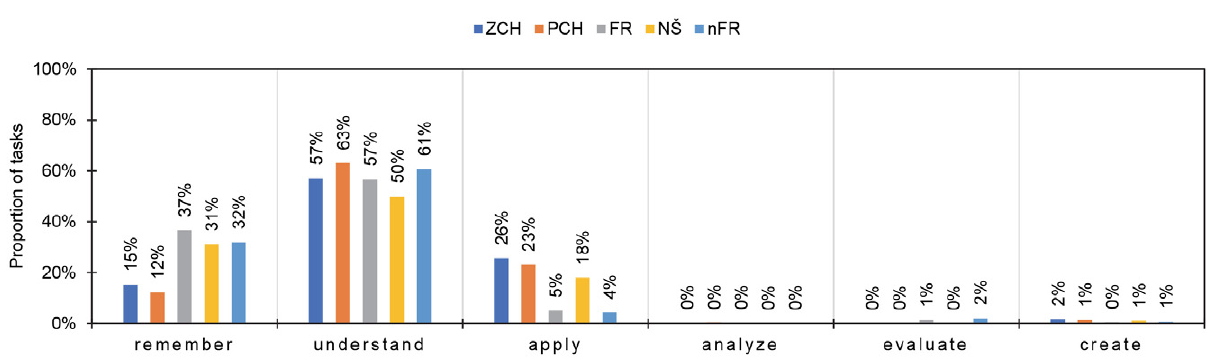
Figure 1 Proportion of tasks in textbooks according to required cognitive operations